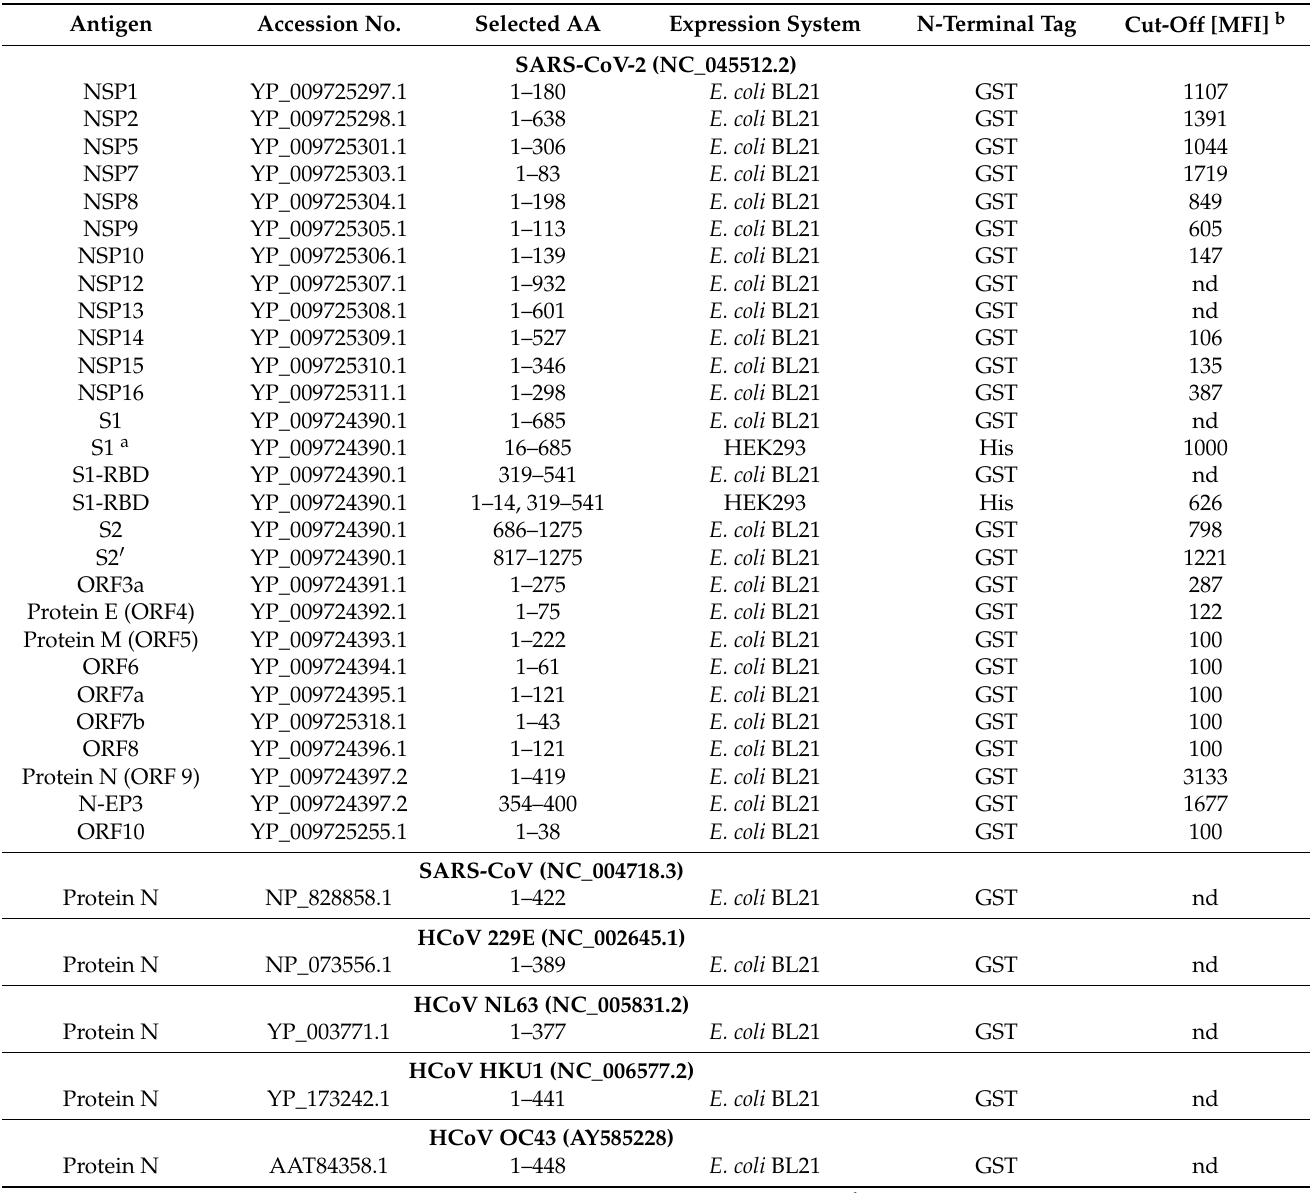
Table 1. Selected proteins of SARS-CoV-2 and additional Coronaviruses for multiplex